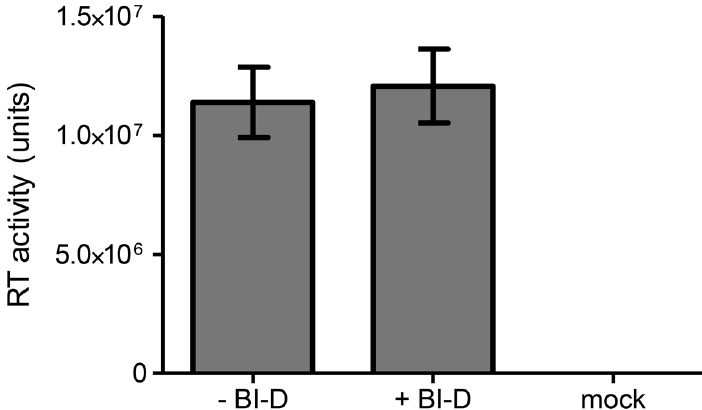
Figure 4. Activity of virus-extracted RT enzyme. Virus was produced with or without BI-D. Virus supernatant was incubated with an MS2 RNA template and dNTPs to reverse transcribe the template RNA. The activity of the RT enzyme was determined by quantitation of the cDNA product by qPCR. Serial dilutions of AMV-RT were used to generate a standard curve. Average values with SD are shown (N=2). Mock: supernatant of cells transfected with control plasmid, pBluescript-SK + .